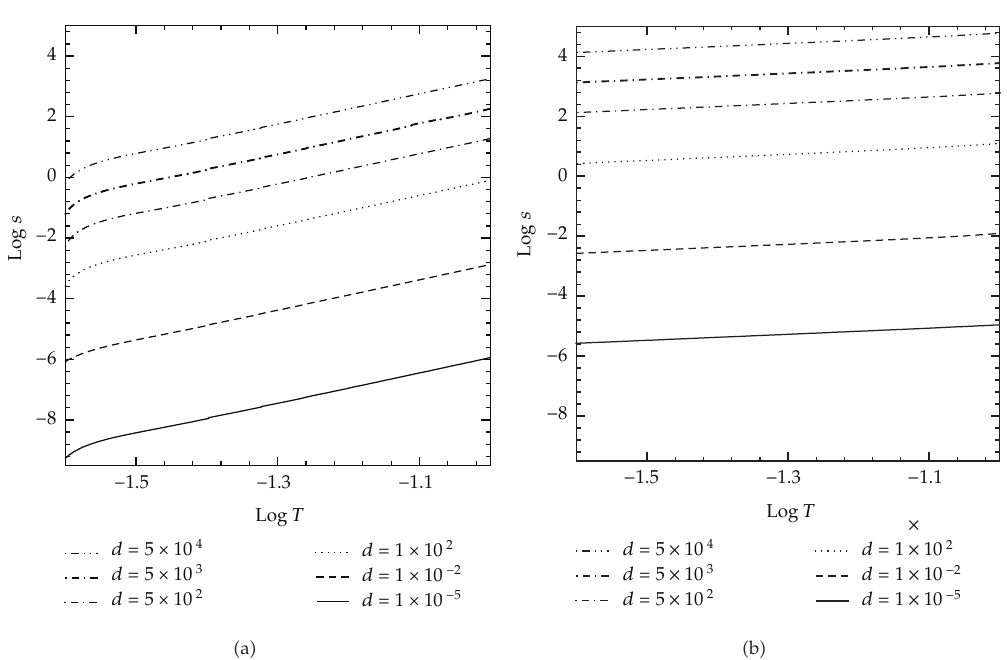
Figure 7: Entropy versus temperature of the multiquark phase in logarithmic scale for n s (cid:8) 0 (cid:3) a (cid:4) , 0 . 3 (cid:3) b (cid:4) .